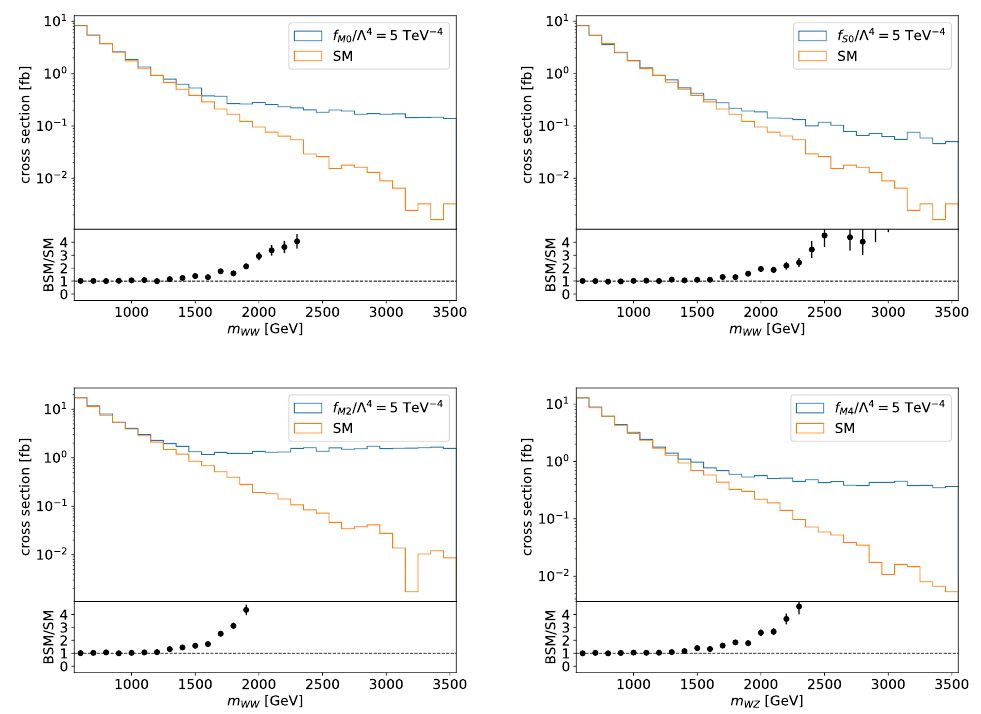
Figure 2 . Examples of differential cross sections highlighting the high invariant-mass region for the processes VBS W ± W ± (top left/top right), VBS W + W − (bottom left) and VBS W ± Z (bottom right). The SM hypothesis is shown, as well as that of a single EFT operator (listed in the legend) with a nonzero coefficient f Λ 4 set to 5 TeV − 4 . EFT-over-SM ratio plots are presented in the X / lower